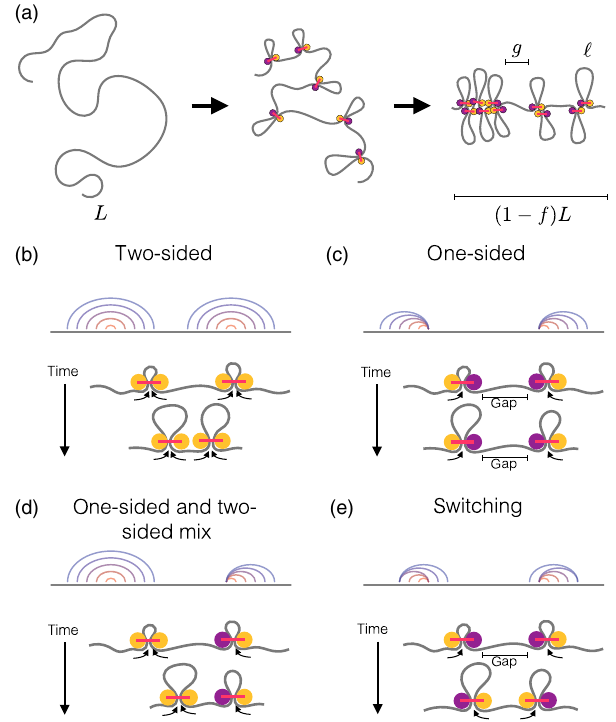
FIG. 1. (a) Linear compaction of chromatin polymer by LEFs. LEFs progressively compact the polymer from its initial length L . In steady state, the polymer is FC -fold compacted into a dynamic loop array with a backbone of length ð 1 − f Þ L . Uncompacted gaps of average size g containing polymer that has not been extruded may remain between loops of size l . (b) Top: Arch diagram showing positions of two two-sided LEFs at different times, with time indicated by color from red (early) to blue (late). Bottom: Drawing of two-sided LEFs (yellow and pink) trans- locating along chromatin/DNA (gray) and progressively growing loops. (c) Arch diagram with time progression of one-sided LEF positions and drawing of one-sided LEFs, each with its inactive head shown in purple. LEFs in the depicted configuration leave an unextruded gap. (d) A mixture of one- and two-sided LEFs. (e) One-sided LEFs that switch which side extrudes can eliminate initially unextruded gaps if at least one of the LEFs